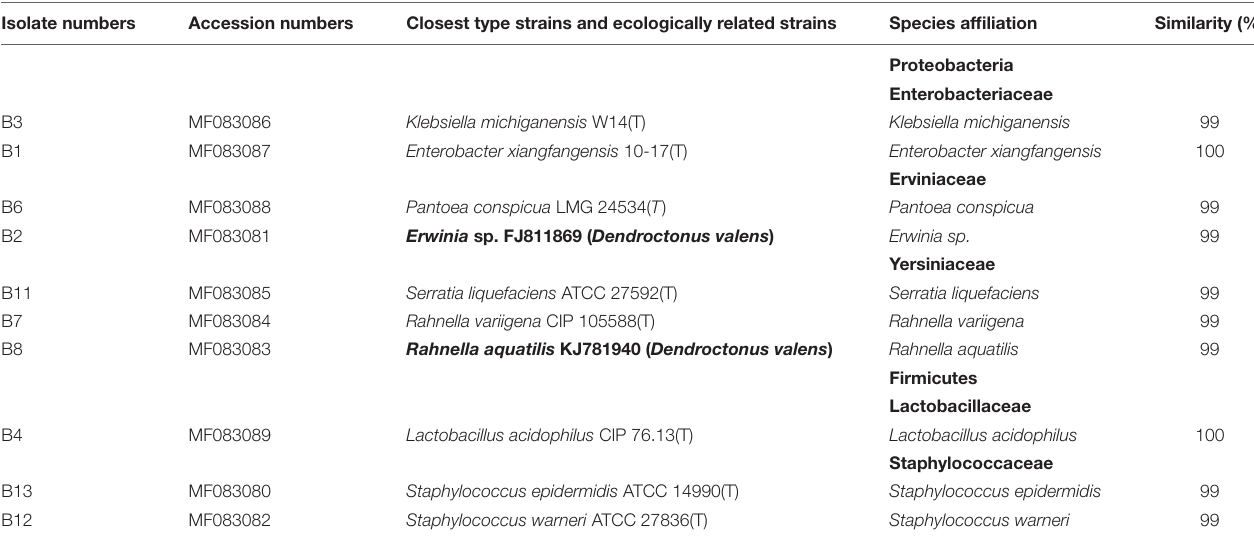
TABLE 1 | Frequently identified isolates of Dendroctonus valens gut associated facultative